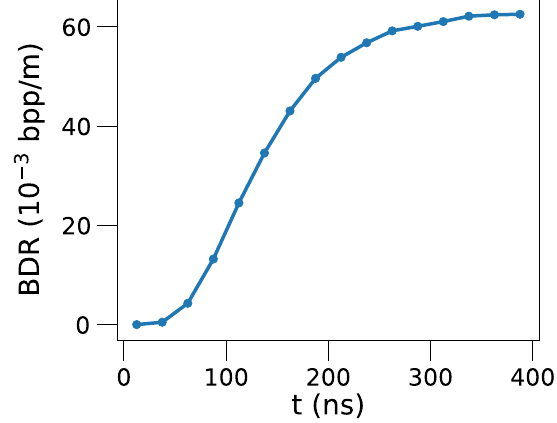
FIG. 15. Probability of a breakdown occurring as a function of the time within the pulse, found by simulation, for the nominal set of parameters, an electric field of 250 MV = m, and a total pulse duration of 400 ns. The probability distribution is presented as a histogram of sixteen bins, each bin 25 ns wide, and normalized by the total BDR at 250 MV = m and a pulse length of 400 ns. The total number of breakdowns is 10 6